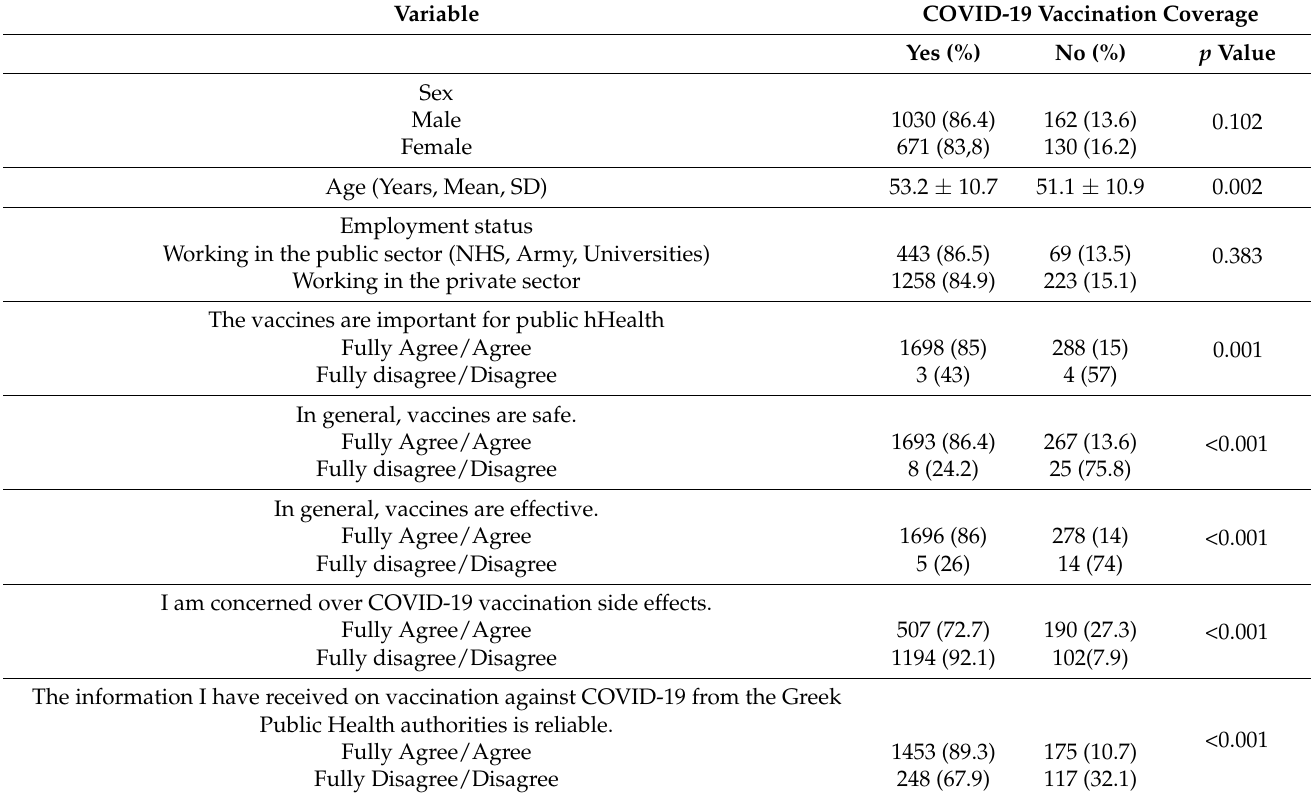
Table 3. Univariate analysis of COVID-19 vaccination